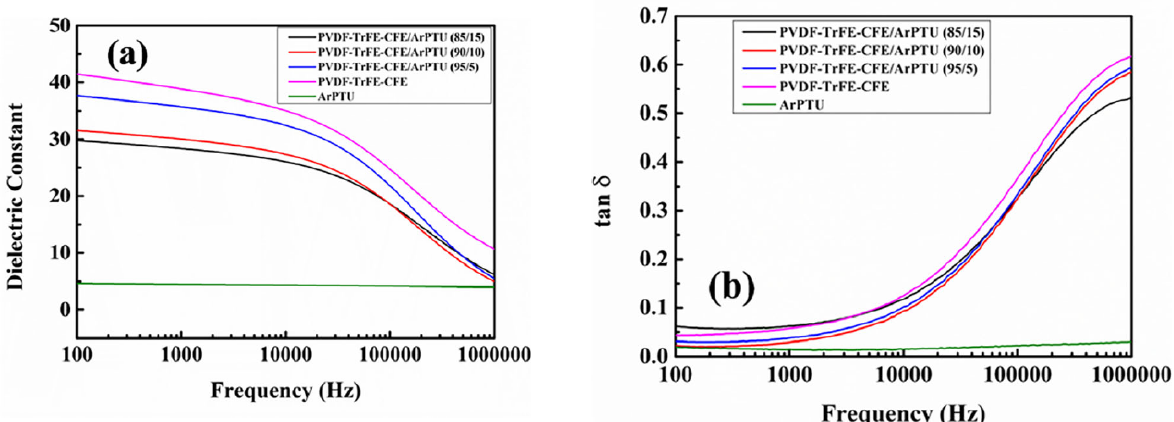
Figure 1. Dielectric constant data for polymer mixes involving PVDF [16]. ( a ) Dielectric constant of ArPTU, PVDF-TrFE-CFE, and PVDFTrFE-CFE/ArPTU composite films; ( b ) Dielectric loss of ArPTU, PVDFTrFE-CFE, and PVDF-TrFE-CFE/ArPTU composite films.